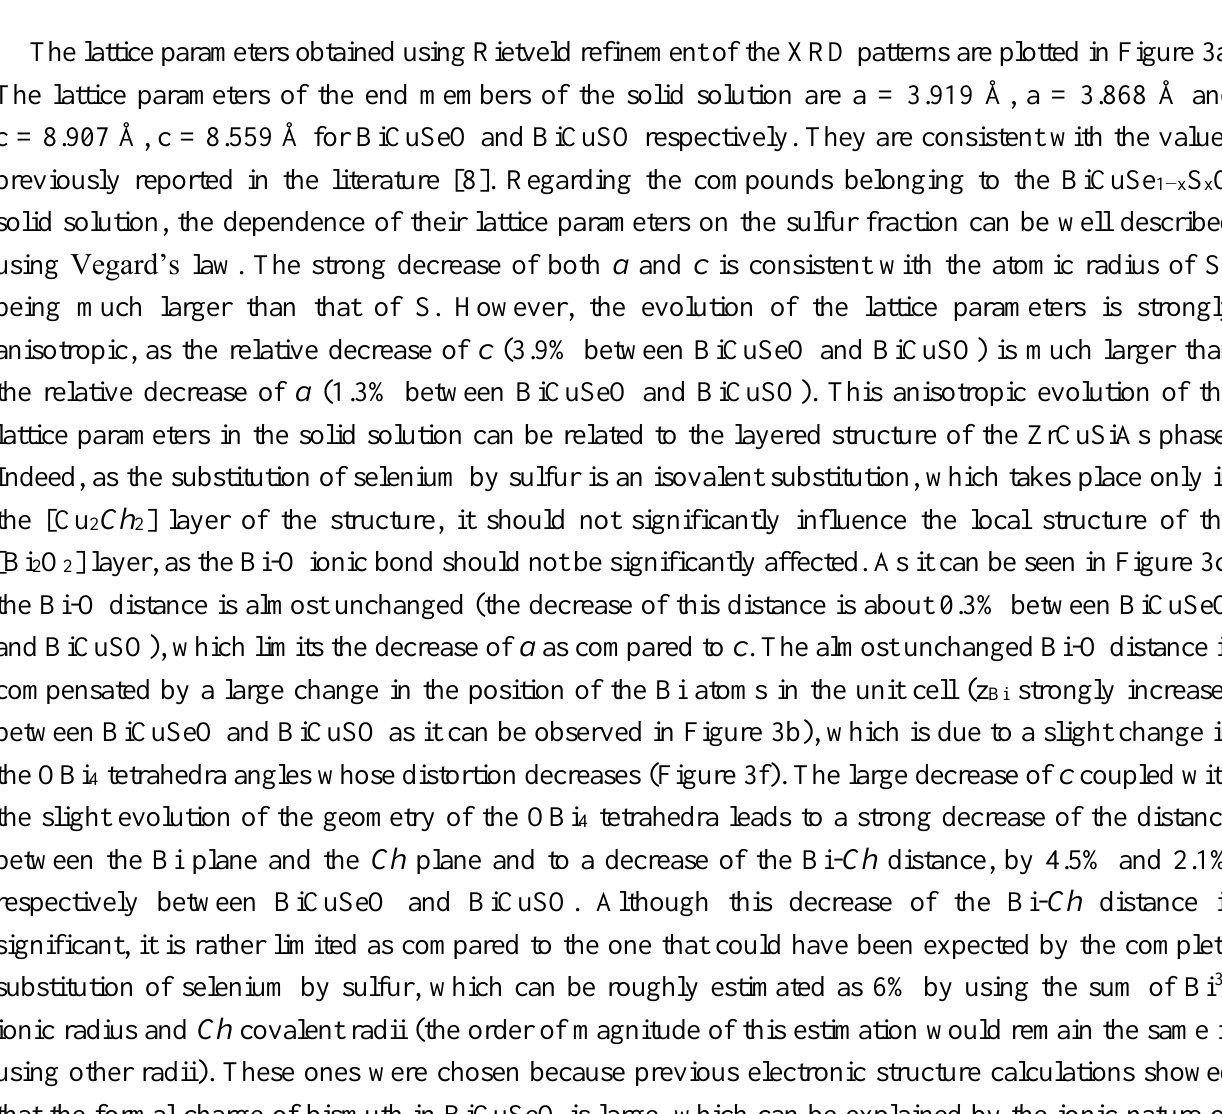
Figure 2. XRD patterns of BiCuSe 1−x S x O samples. The ticks below the patterns indicate the Bragg positions of BiCuSeO. The peak marked with a * corresponds to Bi, and we have not been able to attribute the one marked with a